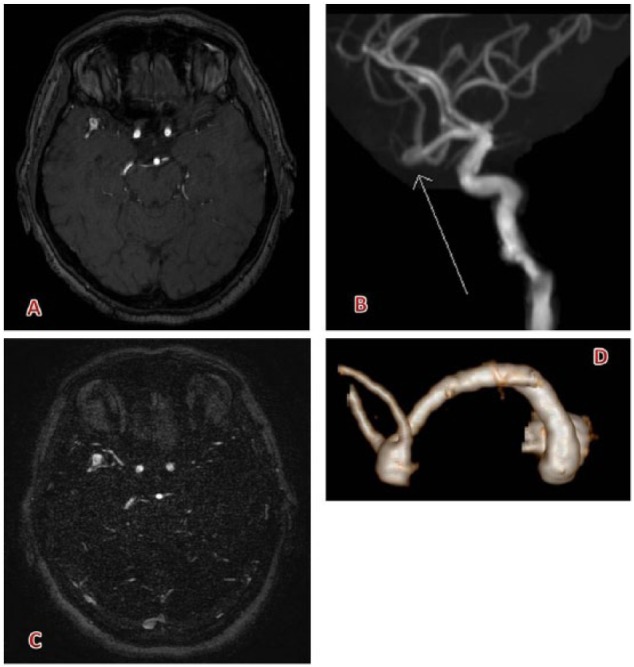
Small aneurysm (6 mm) of the right middle cerebral artery bifurcation: (A) 3D-time-of-flight sequence and (B) relative maximum intensity projection reconstruction, (C) 3D-contrast-enhanced magnetic resonance angiography, and (D) relative 3D surface rendering which allows a better delineation of aneurysm’s morphology. Contrast agent: gadobutrol (7 mL). 3D indicates 3-dimensional.